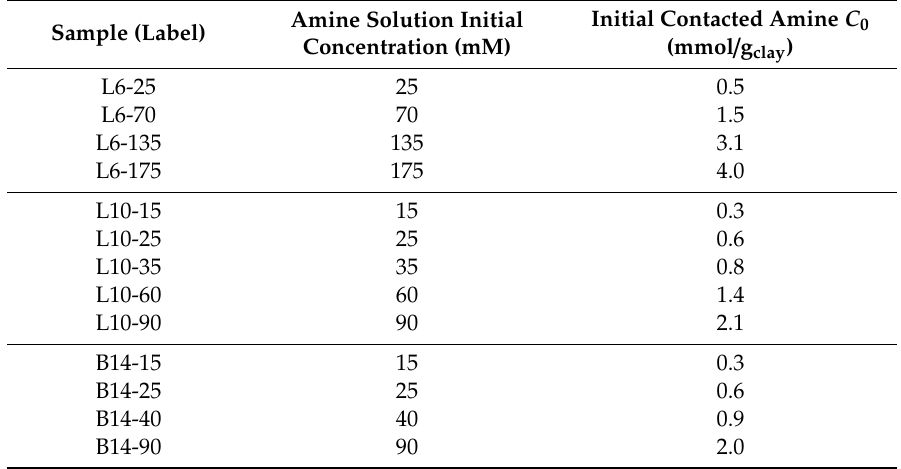
Table 2. Sample labels and initial contacted amine concentration used in the clay modification